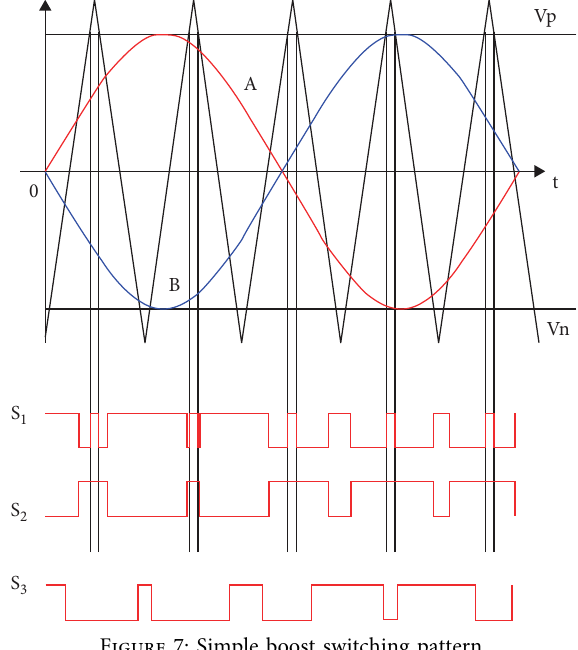
Figure 6: Logical diagram to generate gate pulses.